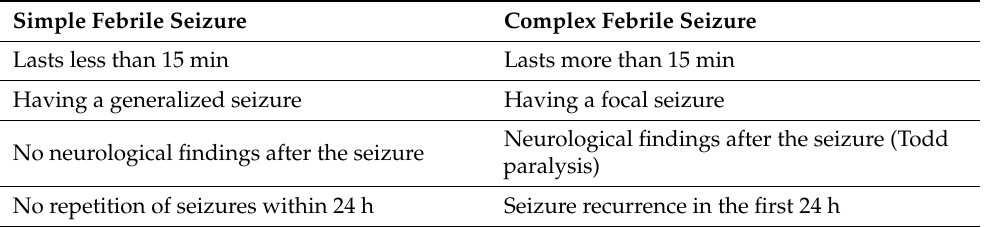
Table 1. Diagnostic criteria used in the differentiation of simple and complex febrile seizures. Simple Febrile Seizure Complex Febrile Seizure Lasts less than 15 min Lasts more than 15 min Having a generalized seizure Having a focal seizure Neurological findings after the seizure (Todd No neurological findings after the seizure paralysis) No repetition of seizures within 24 h Seizure recurrence in the first 24